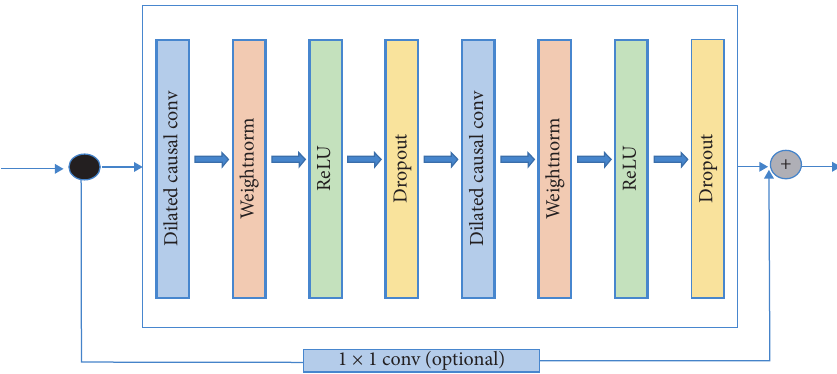
Figure 4: The architecture of TCN residual blocks.